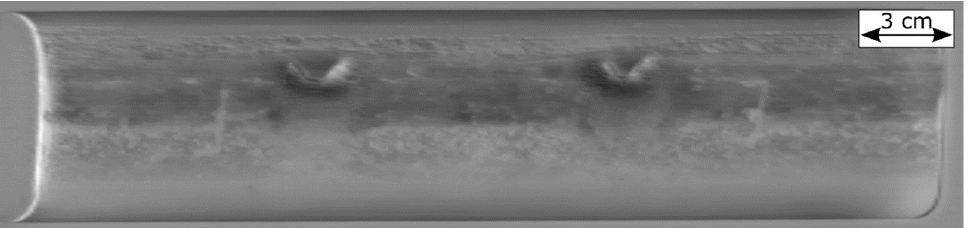
Figure 15. Resulting phase image of a measurement taken with a µ-bolometer camera and a scanning speed of 50 mm/s.